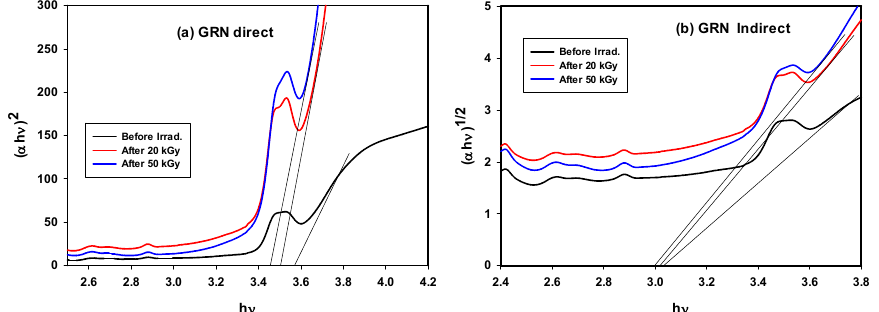
Figure 6. Tauc plot of GRN samples before and after gamma irradiation doses for ( a ) direct and ( b ) indirect energy